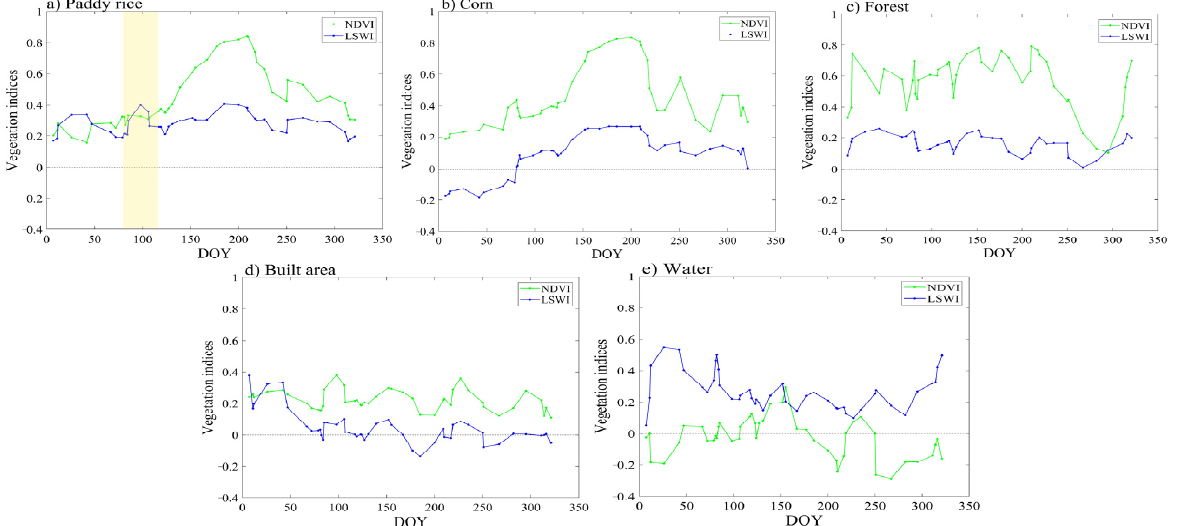
Figure 5. The seasonal dynamics of NDVI and LSWI for the major land use types at selected sites, extracted from fused time series data: ( a ) Paddy rice; ( b ) corn; ( c ) forest; ( d ) built area; ( e ) water. All sites were selected from the field survey data.